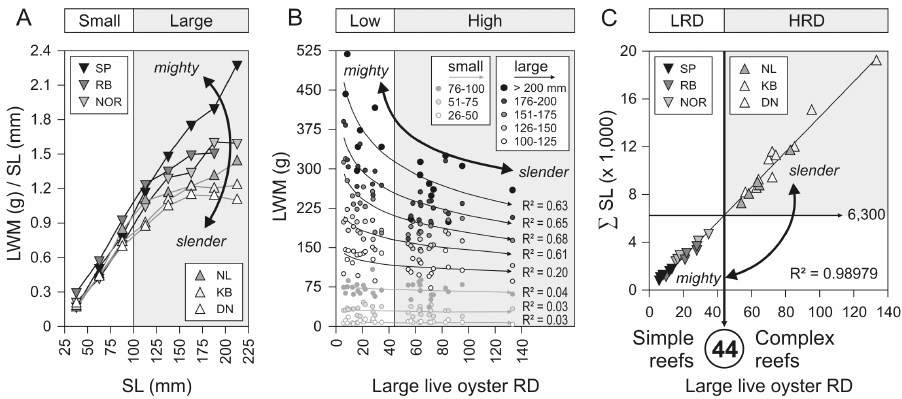
Figure 4. Oyster shape and classification of reef types. A Site- (SP-DN) and size-dependent (small/large) oyster shape. Plotted is individual LWM (g) per SL (mm) against SL (mm) of 8 SL classes per site. B Den- sity-related (low/high) variation of oyster shape. Plotted is individual LWM (g) of 8 SL classes against large live oyster RD per site and year. Exponential trend of density-related shape difference indicated per SL class. C Determination of the threshold density of 44 large live oyster RD to classify sites into simple reefs with low reef density (LRD) and complex reefs with high reef density (HRD). Displayed is the linear relation of large live oyster RD to the sum of their SL. R² = coefficient of